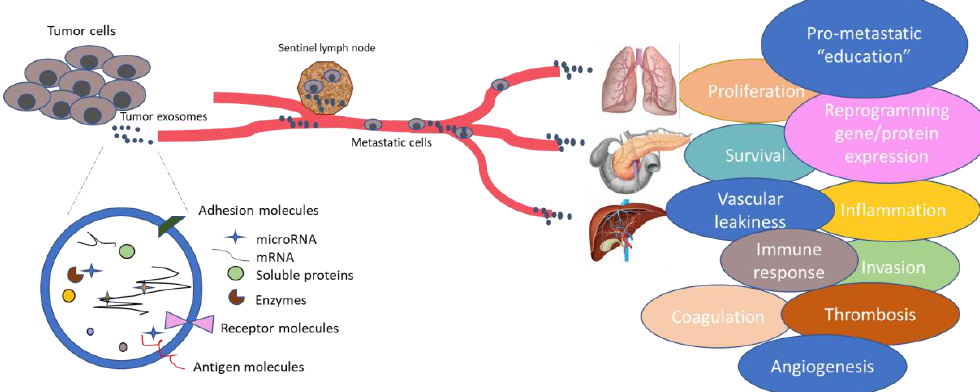
Figure 2. Exosomes released from cancer cells contain important information regarding cancer progression and metastasis. Exosomes are pleiotropic, as they are involved in many steps of cancer, including angiogenesis, invasion, microenvironment education, drug resistance, etc. and represent an important source of biomarkers. Therefore, exosomes could be highly important for the development of future therapies.